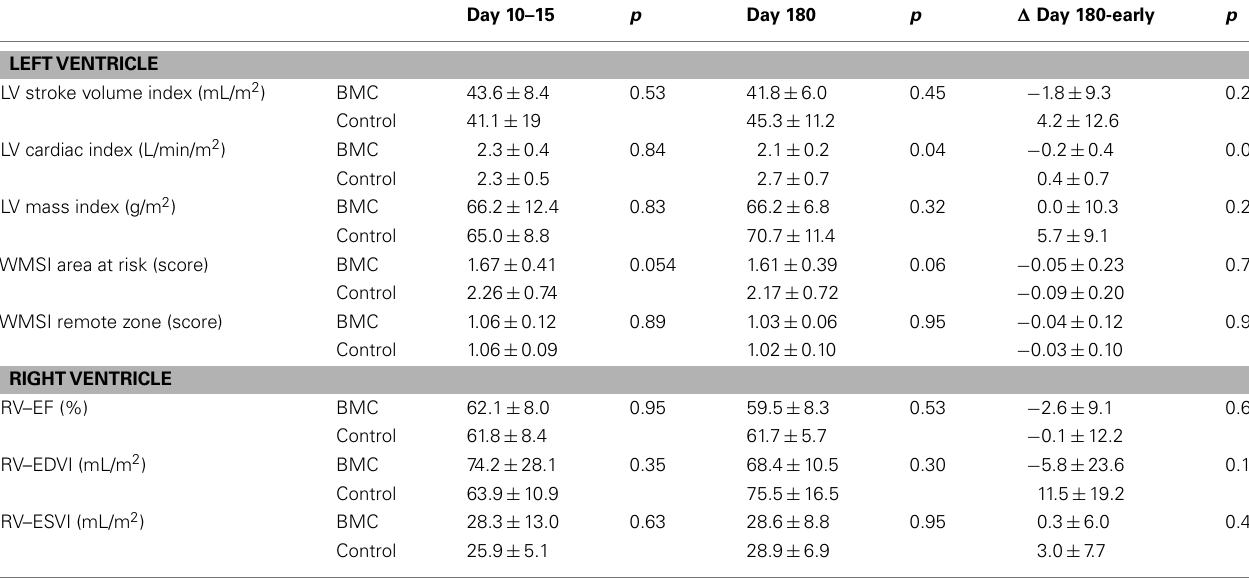
Table 4 | Effect of mononuclear stem cell therapy on left and right ventricular parameters measured by cardiac